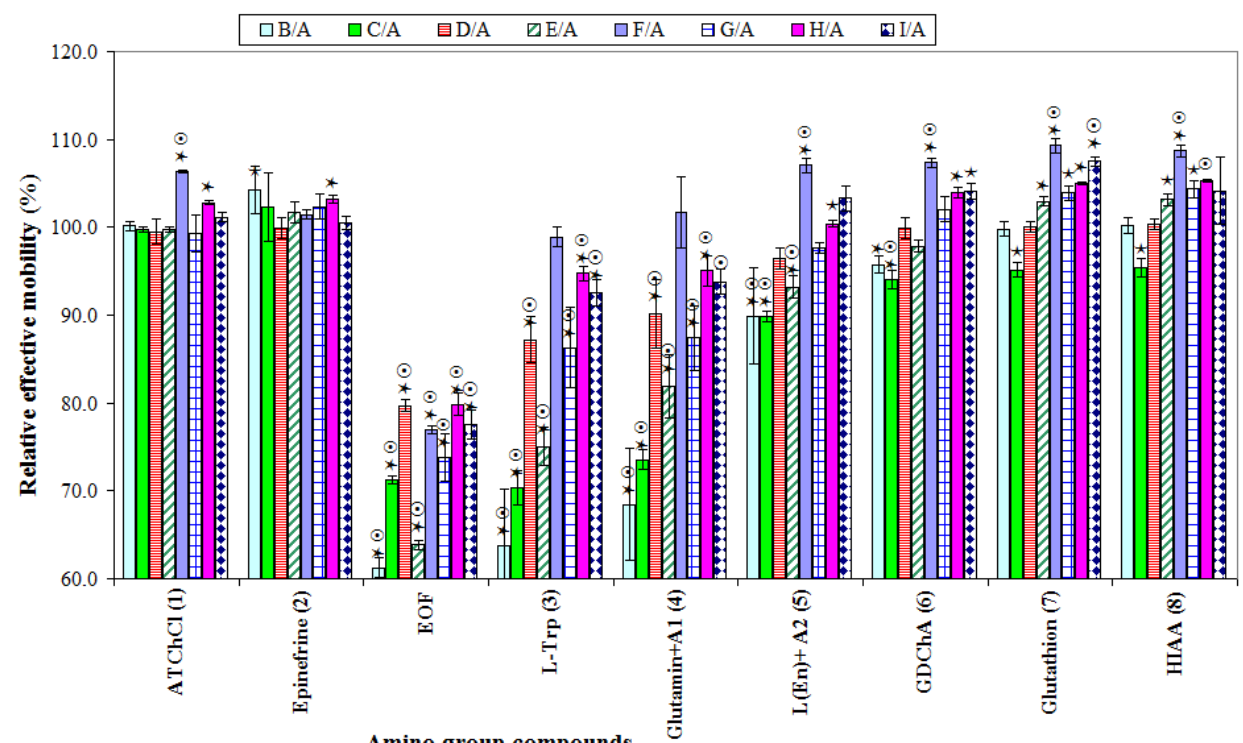
Figure 2. Relative effective mobility changes of amino group compounds in capillaries with modified sol–gels compared to 100% of the capillary with pure sol–gel without additive (line A). A t -test p < 0.05 is marked by the symbol (cid:70) above colored bars. The symbol (cid:12) indicates that the values of the effective mobility changes were greater than ±5% of the standard deviation of Gaussian normal distribution, compared to the pure sol–gel capillary.